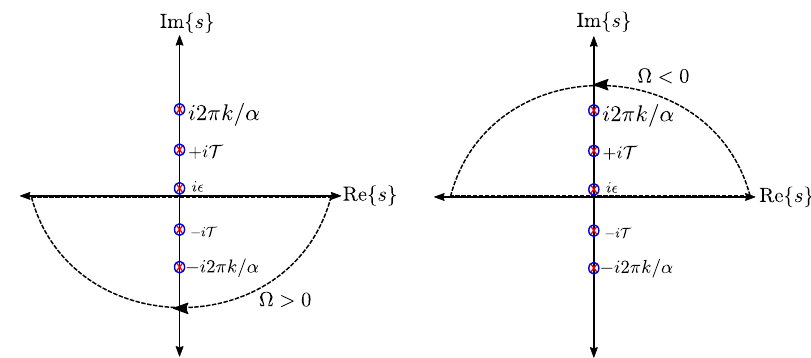
Figure 9. The pole structure of the response functions with Lorentzian regulator is independent of the coupling. The sign of (cid:10) determines which contour we must